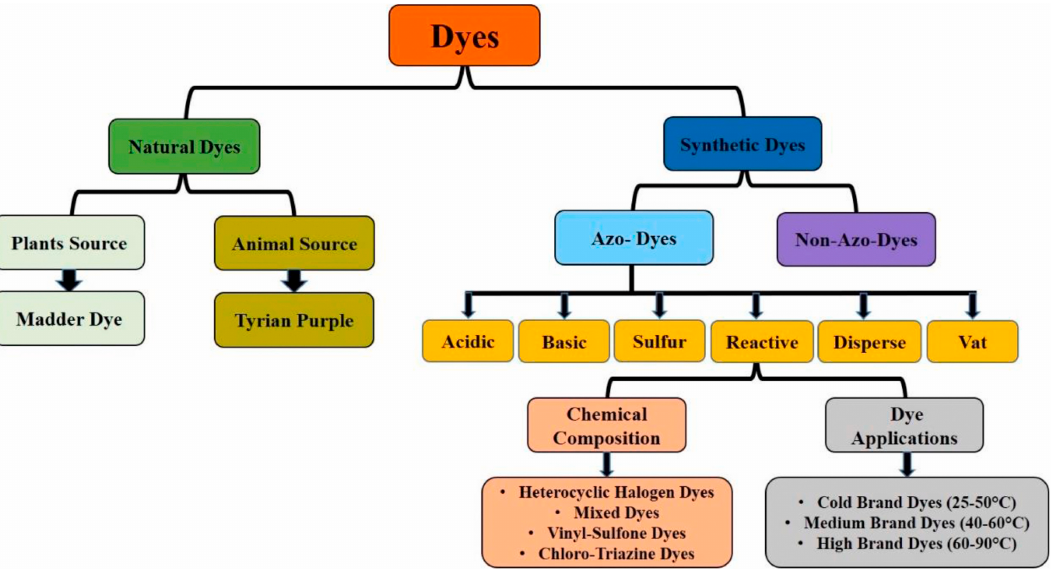
Figure 1. Classi fi cation of dyes based on chemical composition and their applications. Reprinted Figure 1. Classification of dyes based on chemical composition and their applications. Reprinted with permission from [6] . Copyright © 2021 Elsevier. with permission from [6]. Copyright © 2021